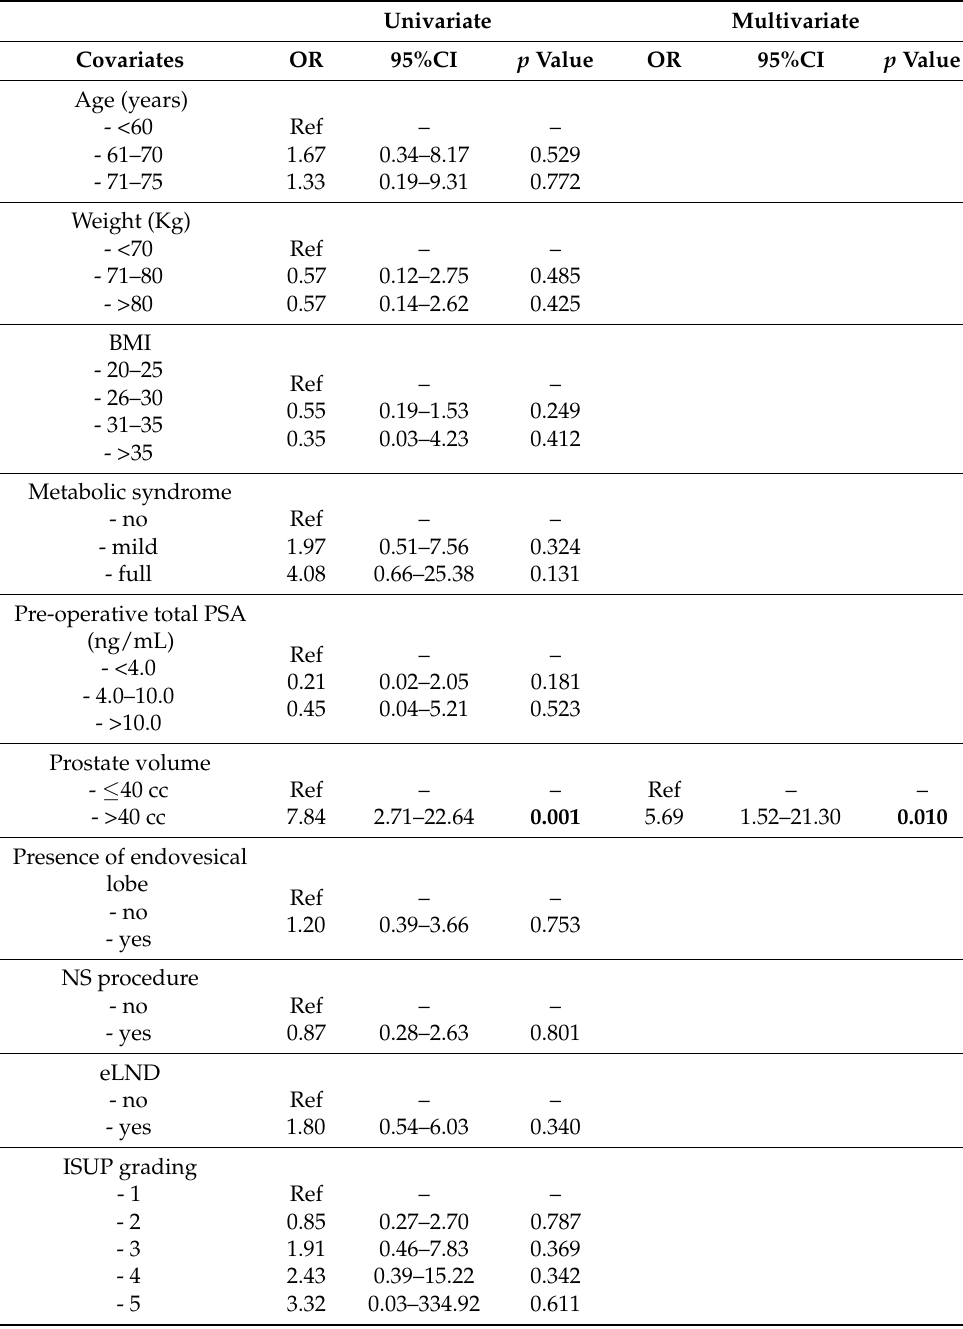
Table 4. Univariate and multivariate stepwise regression model analyses regarding predictive value of different characteristics in terms of pad test results (pad weight at 12-week follow-up > 10 g) (odds ratio (OR), 95% confidence interval (CI) and p value).